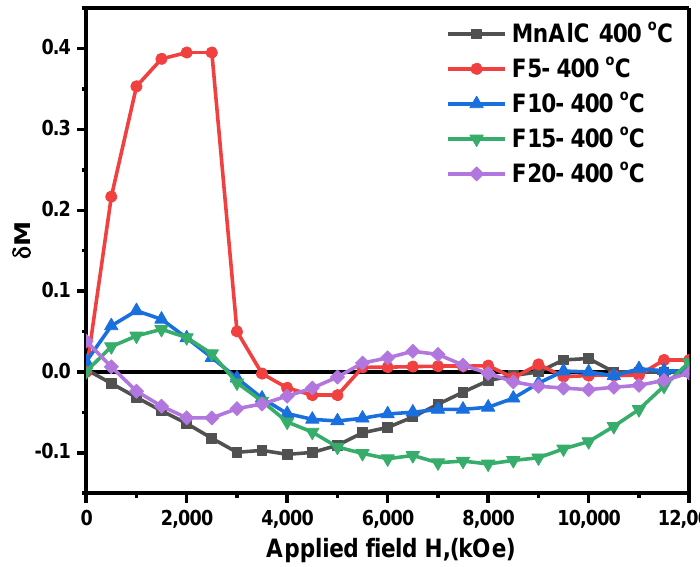
Figure 4. Henkel plots of the samples.